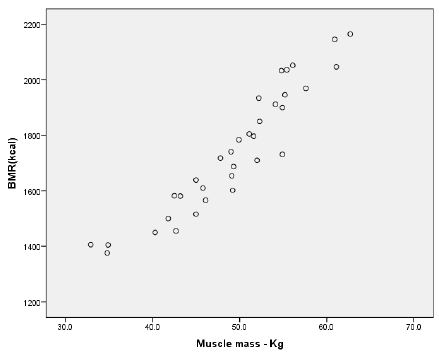
Figure 8. Correlation between BMR and muscle mass (kg) for the group of boys MID.